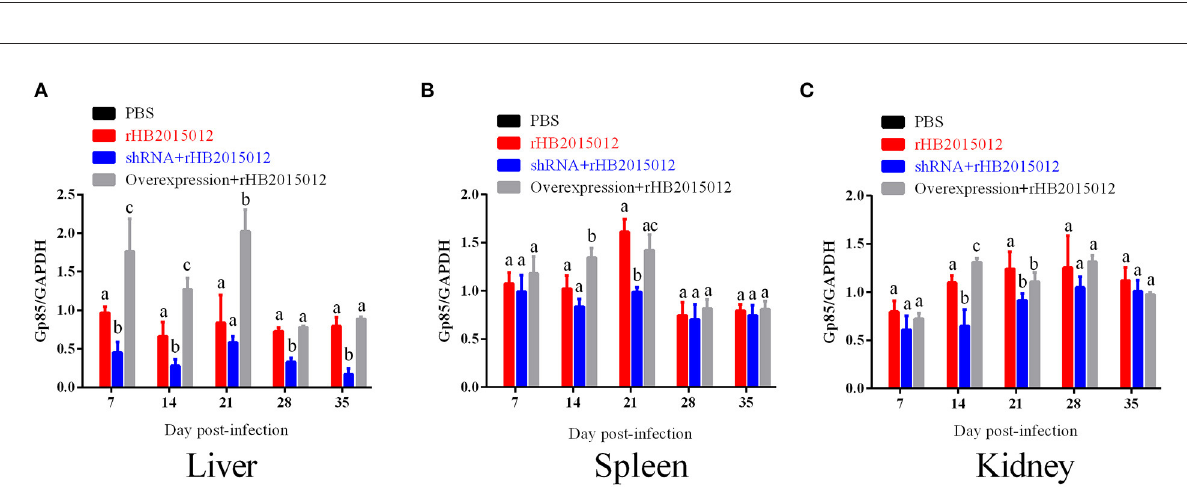
FIGURE8 The viral loads in liver, spleen and kidney after ALV-A infection was determined by Western blotting. (A) Liver viral loads. (B) Spleen viral loads. (C) Kidney viral loads. a, b, and c indicate differences, with the same letter indicating no difference and different letters indicating a difference.